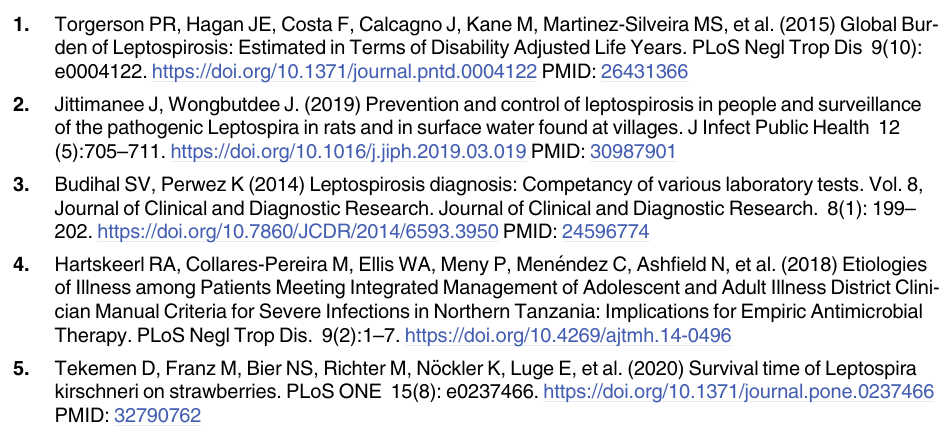
S1 Fig. Simulation plot of predictable variable to validate best fit of model for leptospirosis occurrence predictions in smallholder dairy cattle in